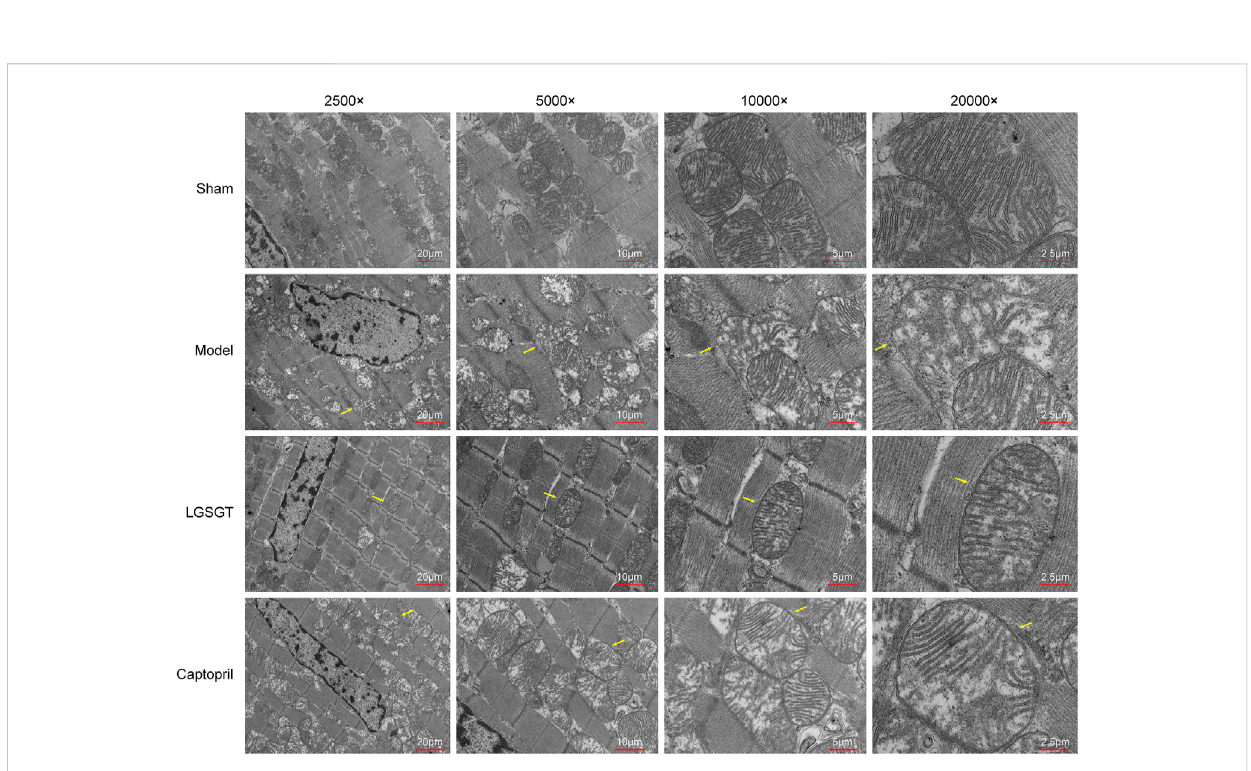
Linggui Zhugan Decoction protects the mitochondria of myocardial cells in rats with heart failure. Observe the differences in the ultrastructure of myocardial cells and mitochondria under the electron